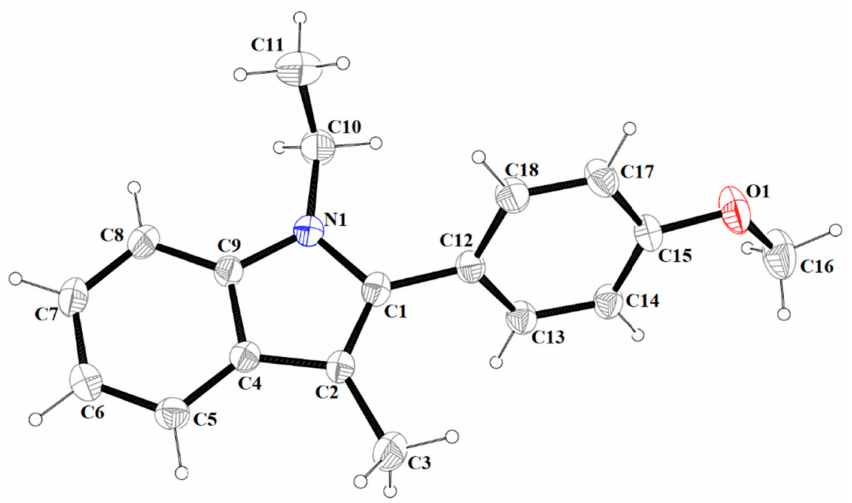
Figure 3. A view of asymmetric unit of 2 , showing the atom-numbering scheme. Displacement ellipsoids are drawn at the 30% probability